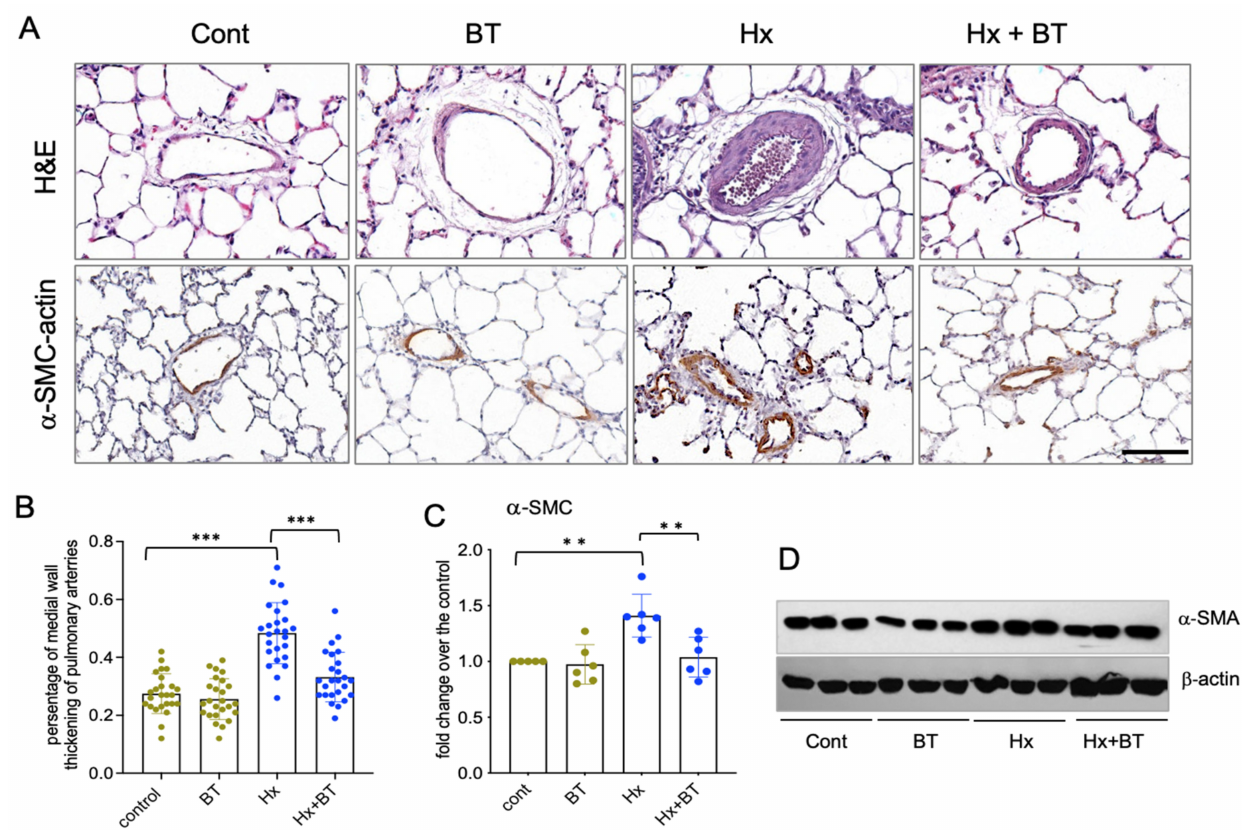
Figure 2. Butyrate attenuates hypoxia-induced pulmonary vascular remodeling. ( A ): Lung sections from control (cont), butyrate-treated (BT), hypoxic (Hx), and butyrate-treated hypoxic (Hx + BT) animals were subjected to H&E and im- munohistochemical analyses with anti α -SMC antibodies; scale = 100 µ M; ( B ): Analysis of medial wall thickening of distal pulmonary arteries. Scanned images of pulmonary arteries (n = 25 for each group) were evaluated using Image Scope software as described in “Materials and Methods”. Data represent a mean +/ − SED; *** p < 0.001; ( C , D ): Western blot analysis of α -SMA expression in total lung lysates. Results are representative from six animals (n = 6) obtained from two independent experiments; data represent a mean +/ − SED; ** p <